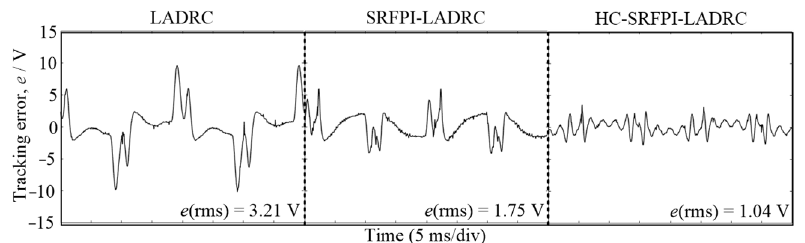
Figure 15. Voltage tracking error of different control strategies under rated resistive load (20 Ω ).